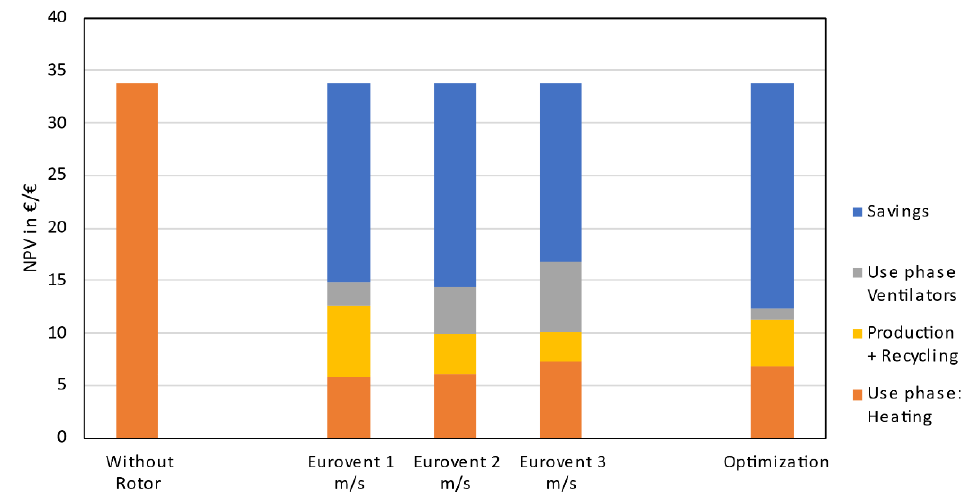
Figure 11. 65 €/t CO 2 Eq. scenario with optimized RHX and Eurovent RHX under different operating ambient air empty tube velocities at 10,000 m 3 /h.